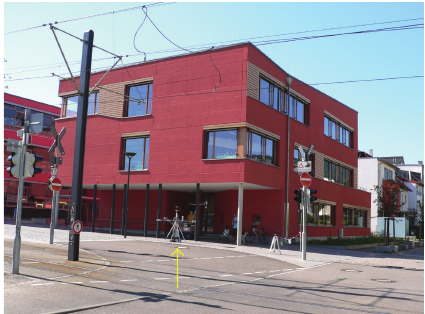
Figure 2: Human-biometeorological measuring site at the NNE- facing sidewalk of a WNW street canyon in Freiburg, “Vauban” quarter, July 15, 2007.